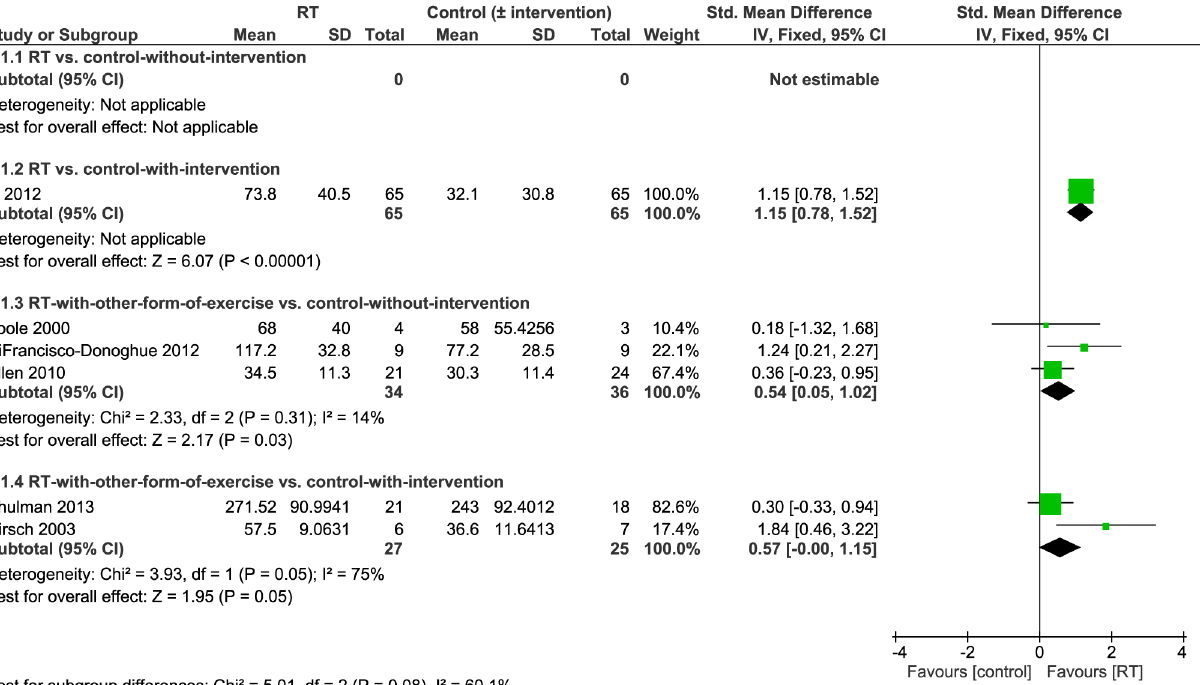
Fig 5. Subgroup analysis forest plot of comparison: RT vs. control-without-intervention, RT vs. control-with-intervention, RT with other form of exercise vs. control-without-intervention, RT with other form of exercise vs. control-with-intervention, using post-intervention values. Outcome: knee extension strength. CI = confidence interval; IV = inverse variance; SMD = standardized mean difference.